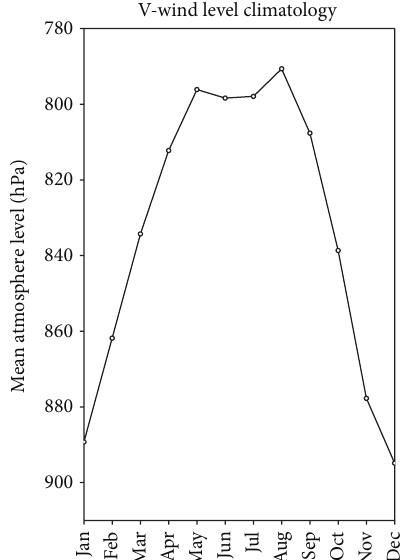
Figure 5: Climatology of the mean atmospheric level reached by the monsoon flow coming from the ocean. Levels are obtained at 6 ∘ N; 5 ∘ W for the level at which the direction of the meridional wind changes from positive to negative